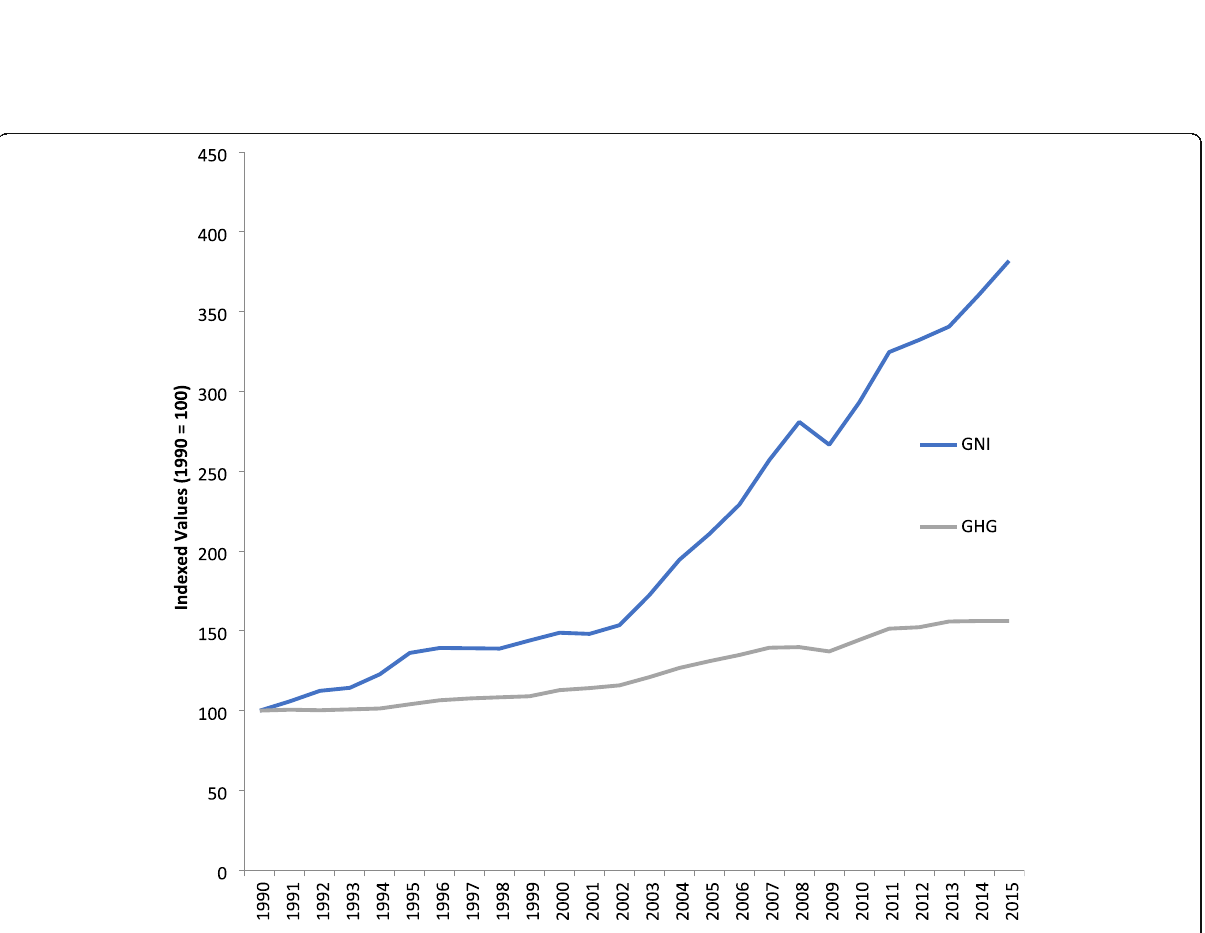
Fig. 4 Economic growth per capita vs Greenhouse gas growth per capita, 1990 – 2015). Source: [28,